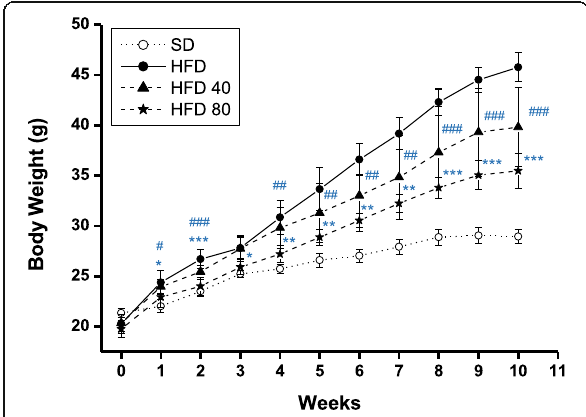
Fig. 8 Body weight changes of male C57BL/6 mice fed a high-fat diet only (HFD), 40 mg/kg purpurin-contained high fat diet (HFD 40), or 80 mg/kg purpurin-contained high fat diet (HFD 80) for 10 weeks. # p < 0.5, ## p < 0.01, and ### p < 0.001 on means of HFD 40 versus high-fat diet. * p < 0.5, ** p < 0.01, and *** p < 0.001 on means of HFD 80 versus high-fat